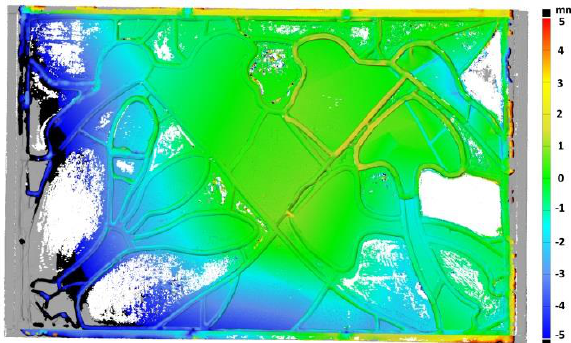
Figure 5. 3D inspection of the outside of the stained glass window nIII from Koszewko before and after its conservation.